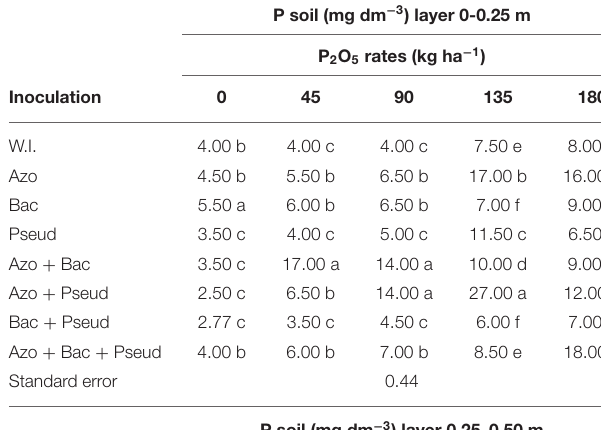
TABLE 3 | Interaction between bacterial inoculations and P 2 O 5 doses for soil available P in the layers of 0-0.25m and 0.25-0.50m. P soil (mg dm − 3 ) layer 0-0.25 m